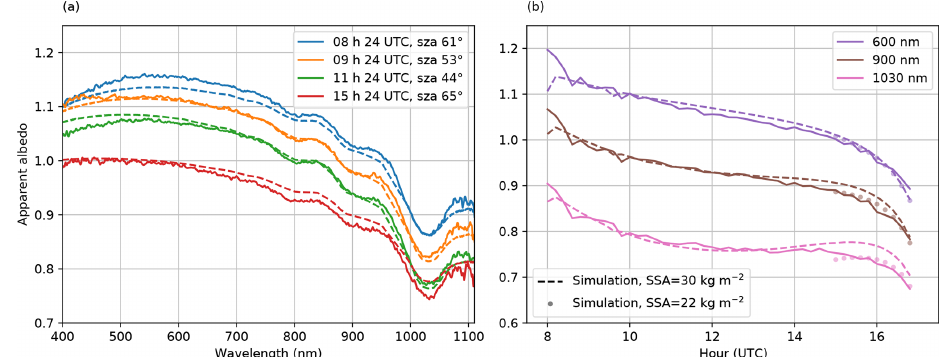
Figure 6. Measured (plain) and simulated (dashed) albedo acquired on 23 March 2018. (a) Albedo spectra acquired at four selected hours during the day; (b) albedo as a function of time for three selected wavelengths.